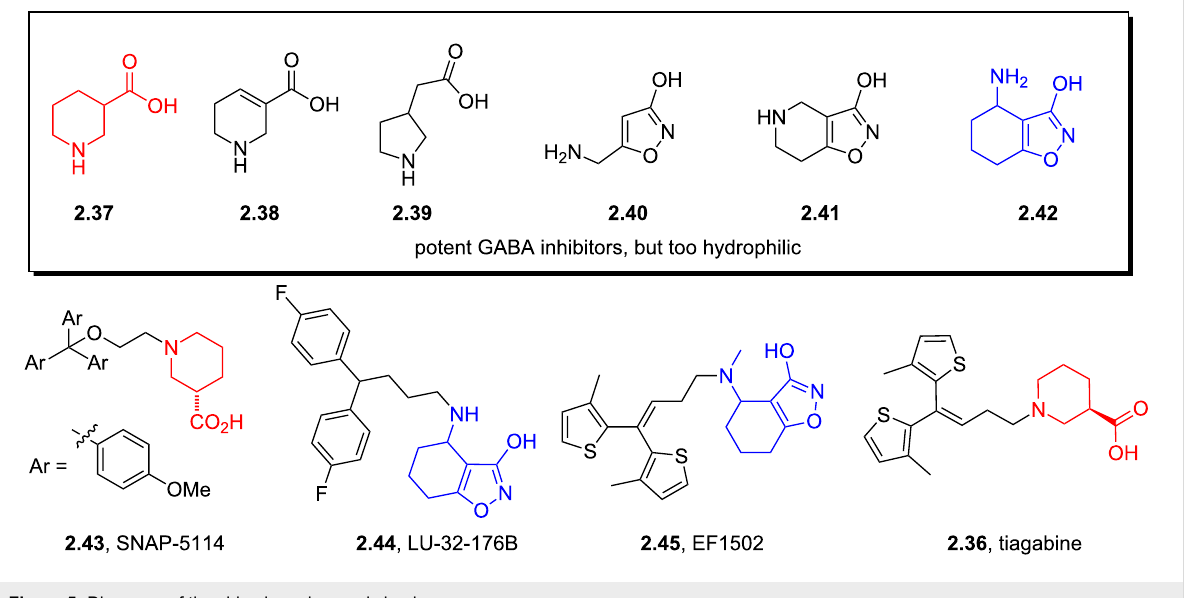
Figure 5: Discovery of tiagabine based on early leads.